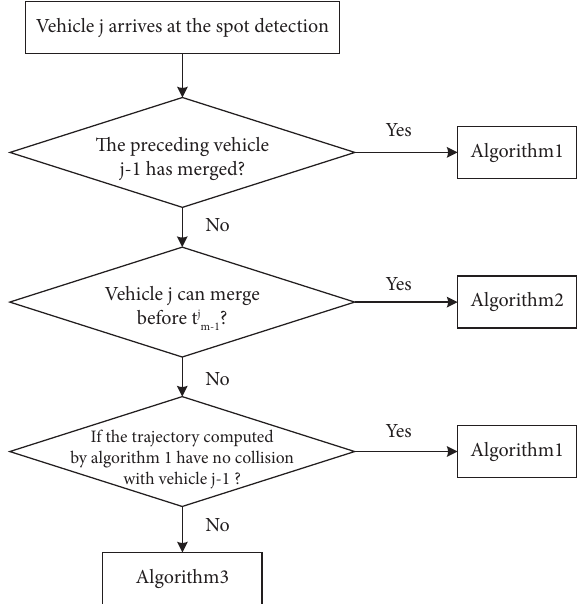
Figure 4: Te fowchart of the merging method with cooperative velocity